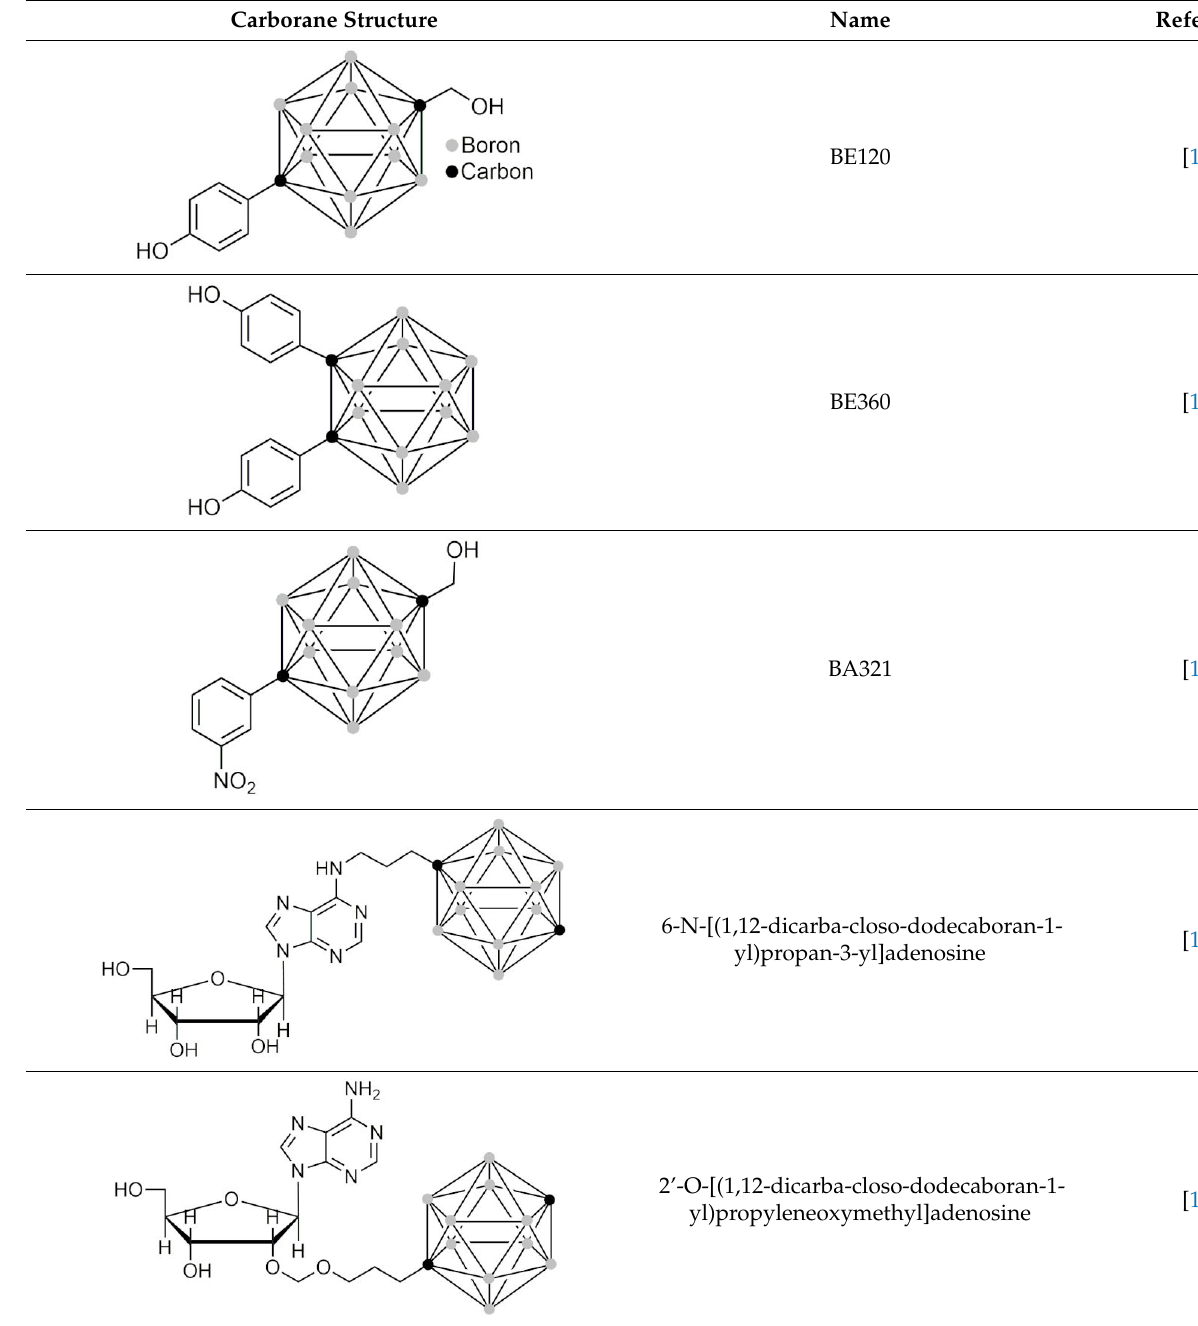
Table 6. Carboranes as steroid agonists/antagonists and carborane-modified nucleosides. Carborane